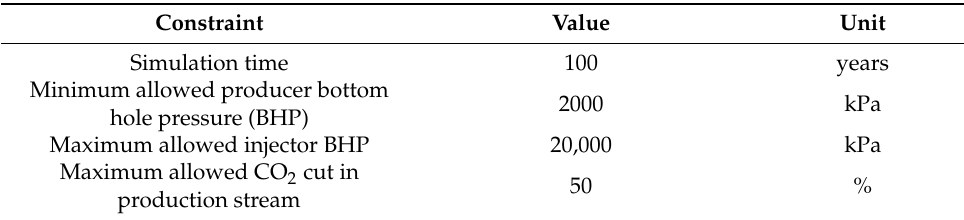
Table A2. Simulation constraints for the synthetic reservoir